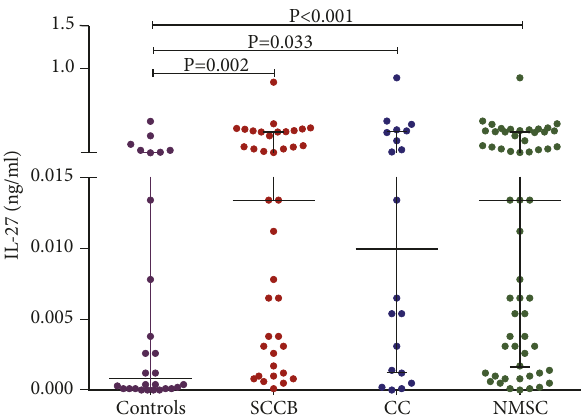
Figure 1: Scatter dot plot diagram of IL-27 serum levels; the middle line represents the median levels of serum IL-27. The ends of the whiskers represent 10-90 percentile; outliers are plotted as individual points; SCC: Squamous Cell Carcinoma; BCC: Basal Cell Carcinoma; NMSC: nonmelanoma skin cancer (SCC+BCC); IL-27 serum levels were significantly higher in NMSC, SCC, and BCC patients in comparison to controls (0.0134, 0.0134, and 0.0100 ng/ml respectively versus 0.0008